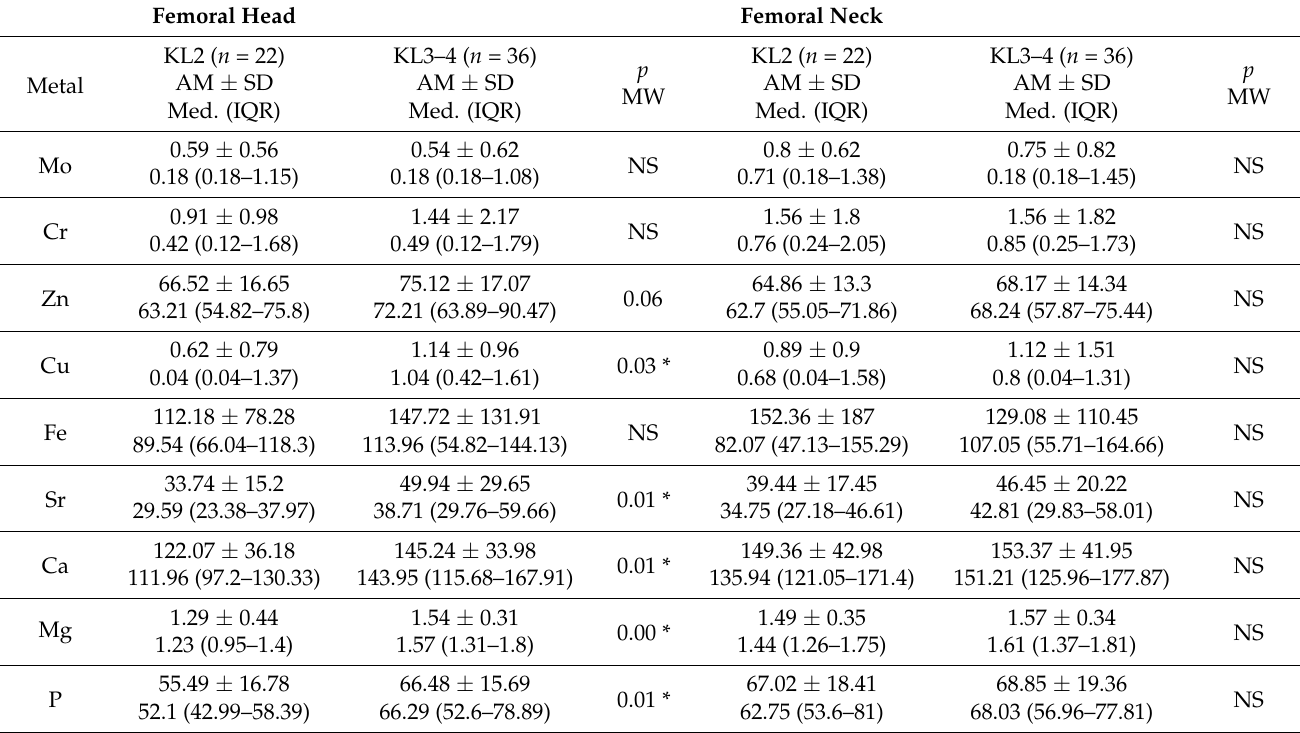
Table 2. Concentrations of enzymatic and oxidation metals (Mo, Cr, Zn, Cu, Fe, Sr in mg · kg − 1 on dry mass basis) and structural elements (Ca, P, Mg in g · kg − 1 on dry mass basis) differences between mild and severe grade of OA in femoral head and neck ( N = 58).